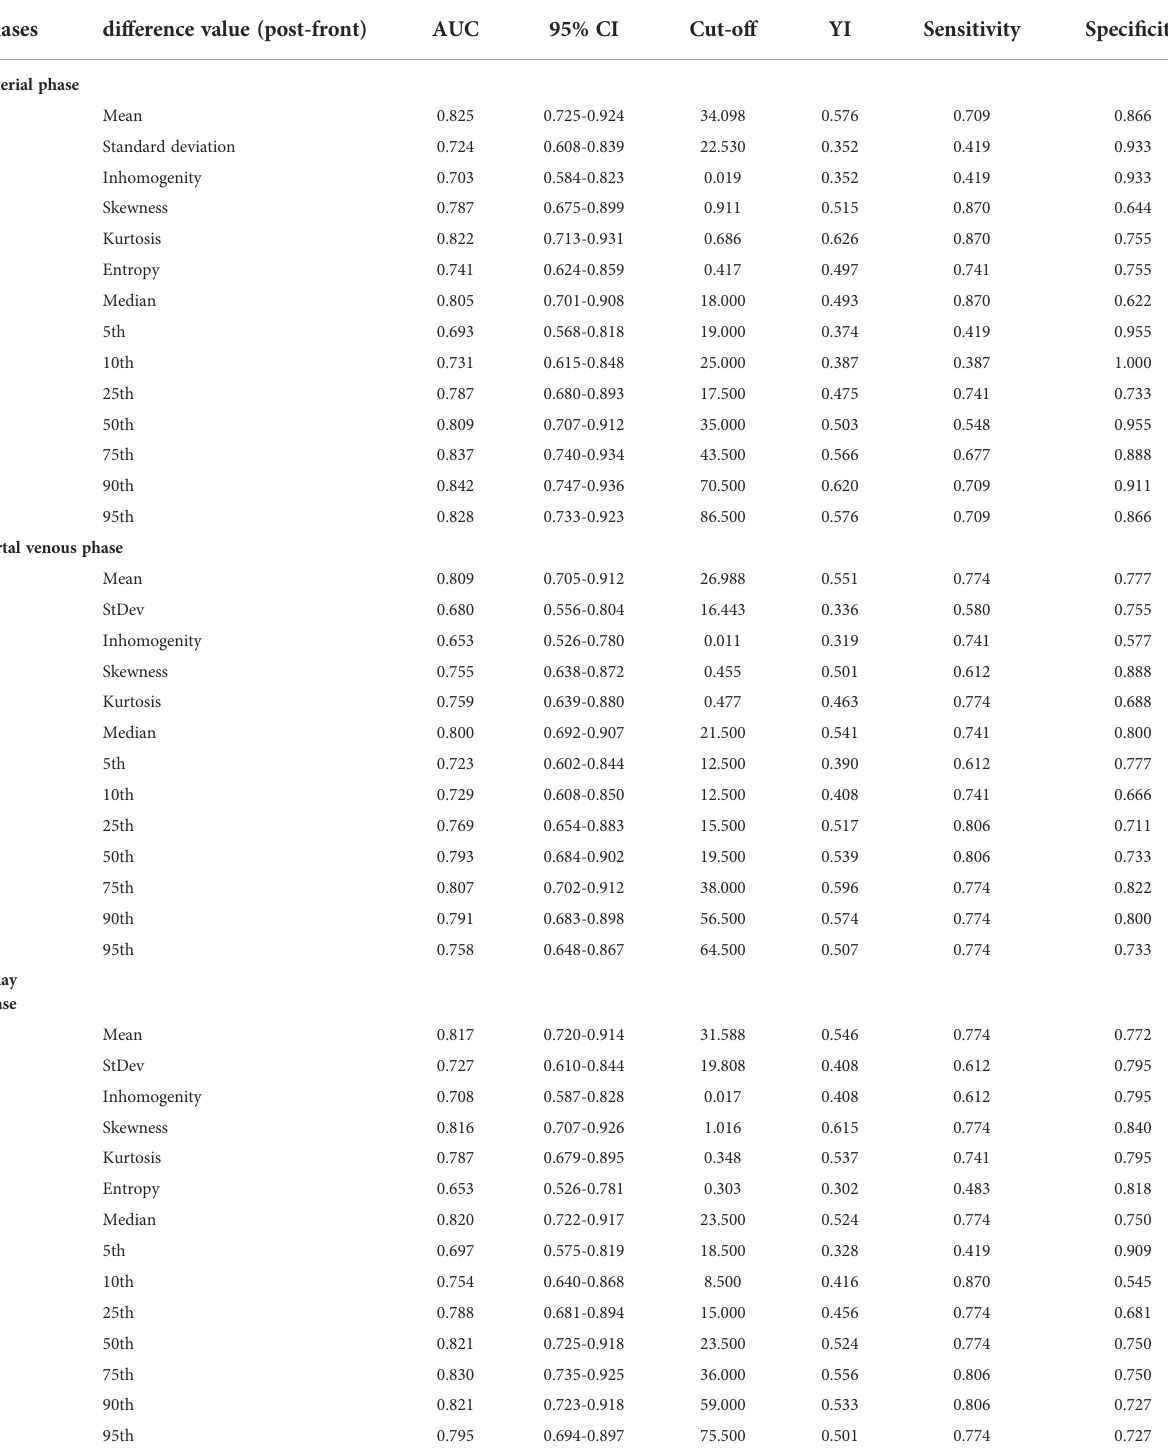
TABLE 3 Diagnostic performance of statistically signi fi cant grayscale histogram parameters.